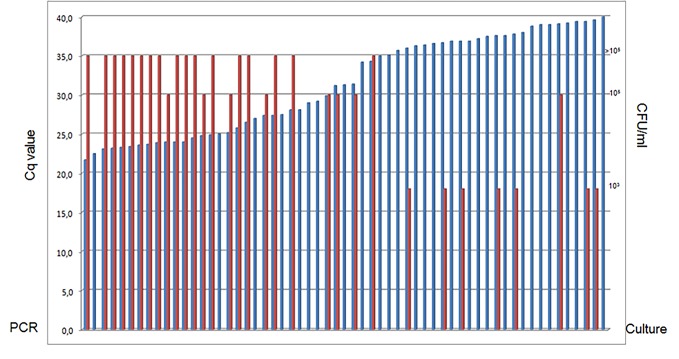
Graphic showing the correlation between positive cultures and PCR Cq values.Comparison of PCR and culture results for E. coli. Cq values of PCR are depicted in the blue bars ranging from Cq22-Cq40 on the left axis. The red bars depict positive cultures with growth of 103, 105, and >105 cfu/ml on the right axis. Low Cq values correspond with high loads of micro-organisms, and thus with larger yield of positivity and quantities of cultures.